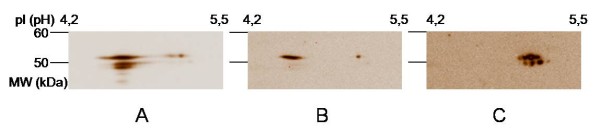
Different isoforms of vimentin on Western blot. Immunodetection with anti-vimentin on Western blot. A: shows the combination of the acidic (pI = 4.6) and the basic (pI = 5.3) isoform of vimentin; B: acidic isoform of vimentin; C: the basic isoform of vimentin. The acidic isoforms (A and B) correspond with citrullinated vimentin as detected with AMC.